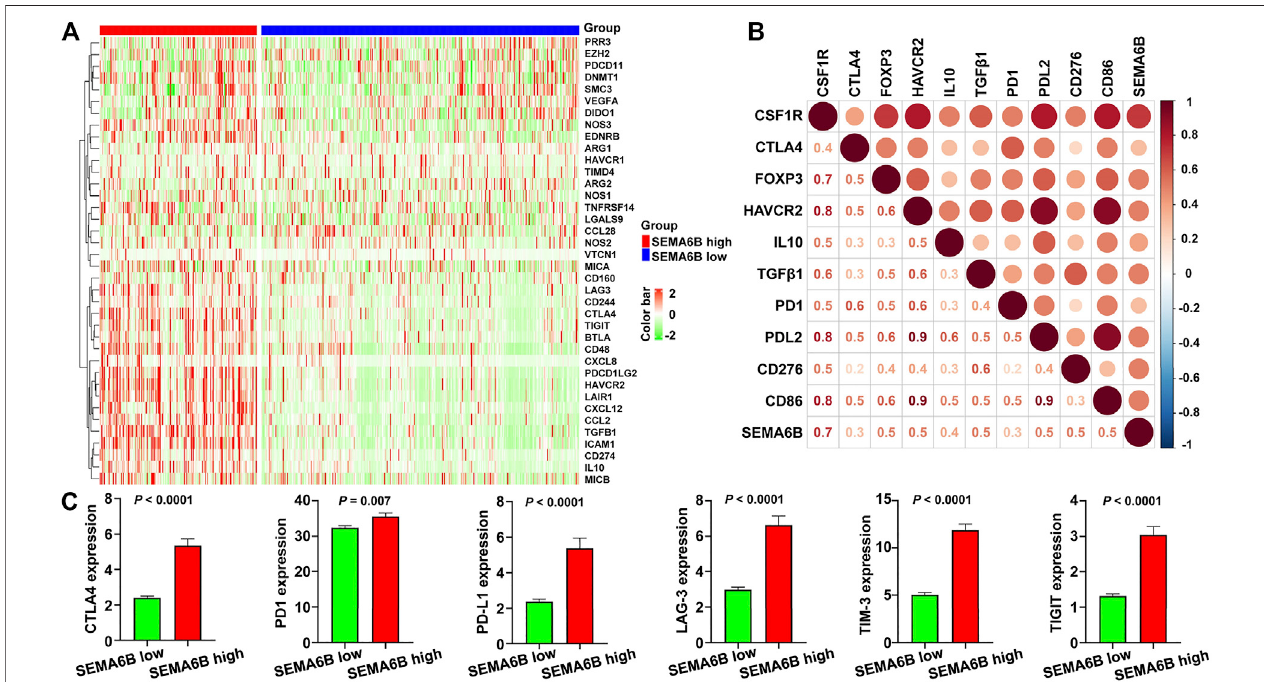
FIGURE 9 | High SEMA6B expression indicates the tumor immunosuppressive microenvironment. (A) Heatmap of the gene pro fi les involved in the negative regulation of the cancer-immunity cycle in the high and low SEMA6B expression groups using the TCGA-CRC cohort. (B) Heatmap displaying correlations between SEMA6Bexpressionandimmunosuppressivegenes.ThenumberineachsmallboxindicatesthePearsoncorrelationcoef fi cientbetweenthetwocorrespondinggenes. (C) Comparisons of the expression levels of representative immune checkpoint genes in the high and low SEMA6B expression